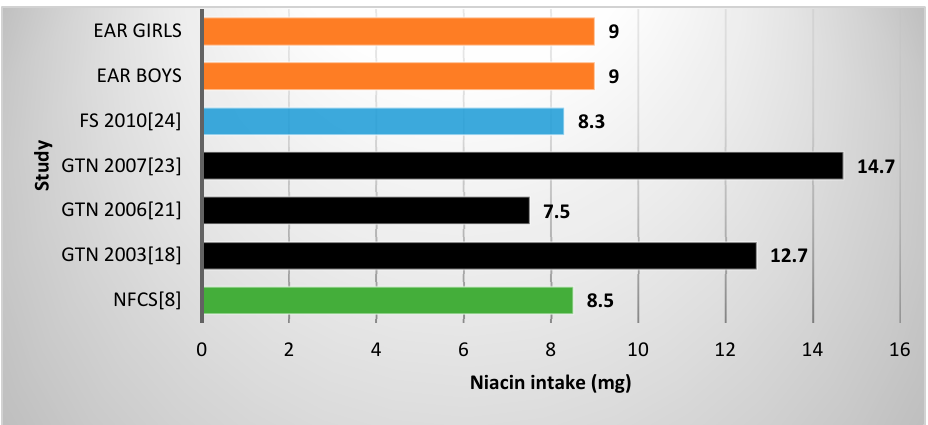
Figure 8. Mean niacin intake in studies on schoolchildren in South Africa between 2000 and 2015 with the blue bars representing one study which included fortification values. EAR: estimated average intake; GTN: Gauteng; FS: Free State; NW: North West; NFCS: National Food Consumption Survey.